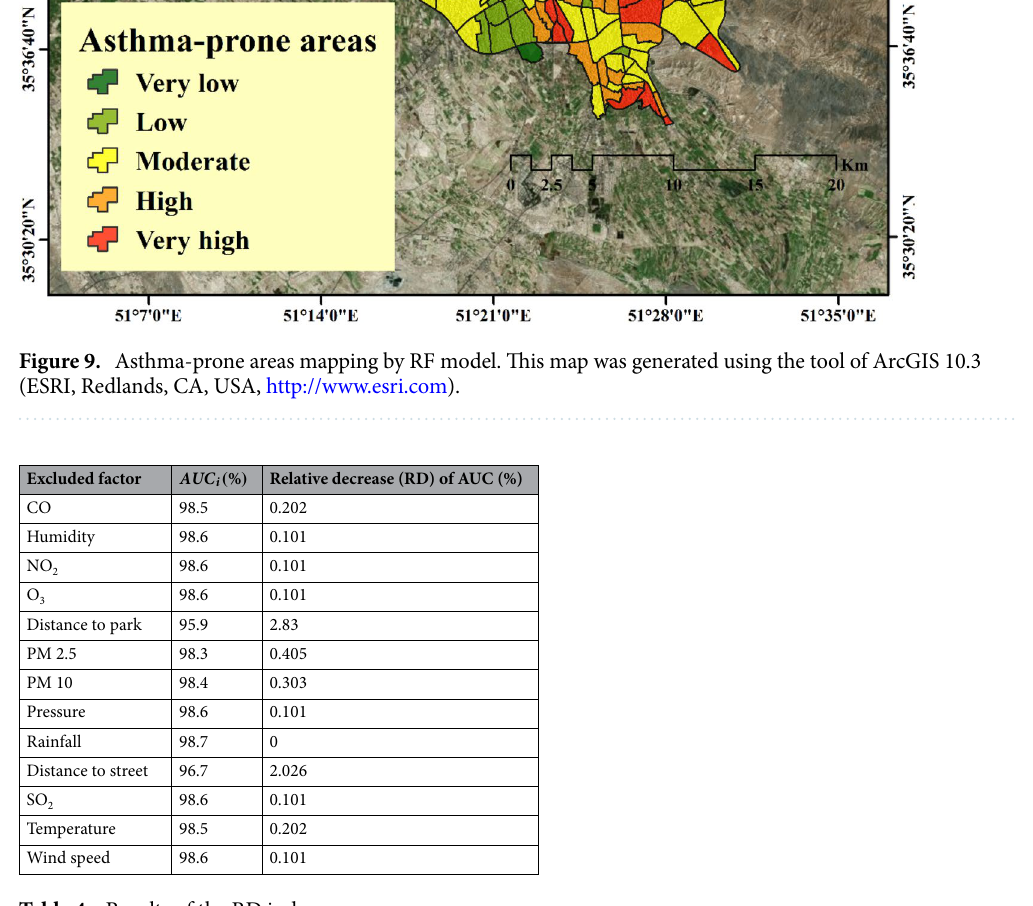
Table 4. Results of the RD